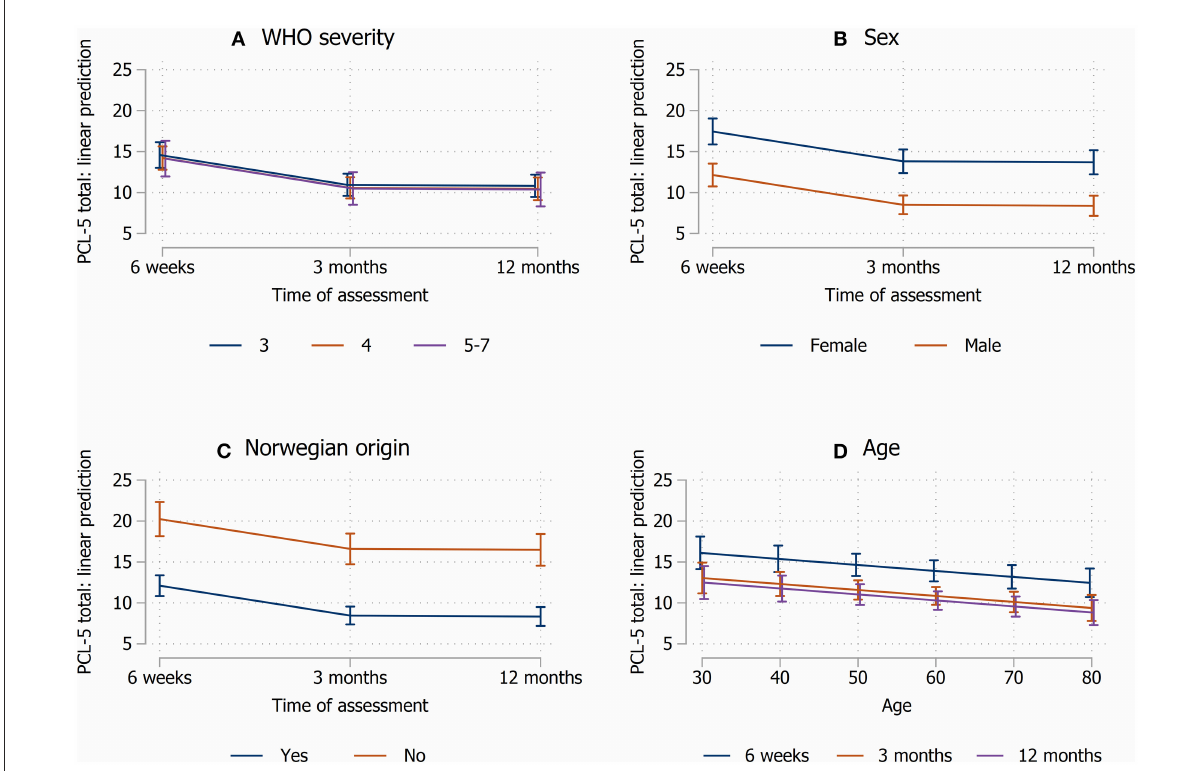
FIGURE2 Margin plots from the linear mixed models, illutrating the effects of covariates on estimated PCL-5 scores over time. (A) WHO ordinal disease severity, (B) sex, (C) Norwegian origin, and (D) age. Other covariates than those shown were kept at mean values.